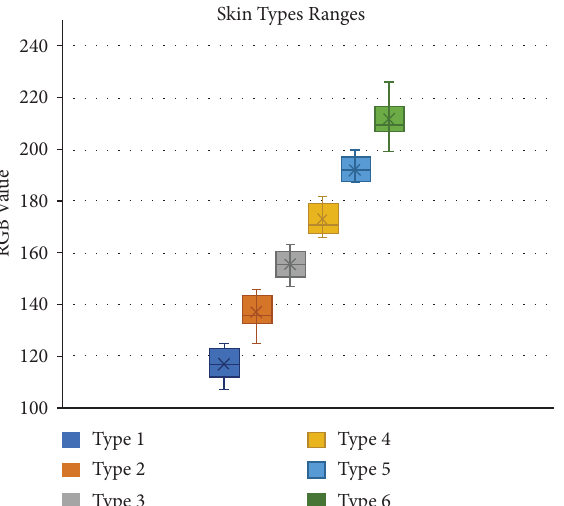
Figure 2: Final ranges of each skin type depending on the database that built using collected measurements from the color